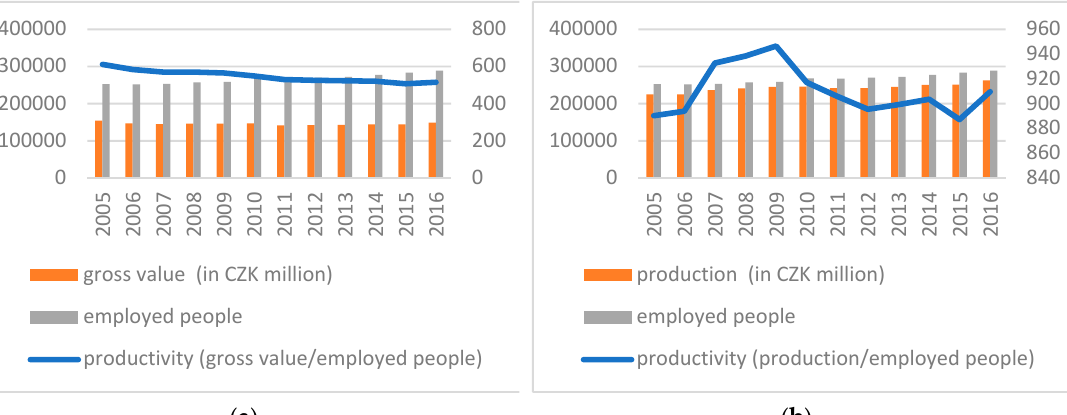
Figure 1. ( a ) Gross value added at constant prices (in CZK million, the number of employed people, productivity; ( b ) production at constant prices (in CZK million), the number of employed people, productivity; the Health and Social Care sector, the Czech Republic 2005–2016.